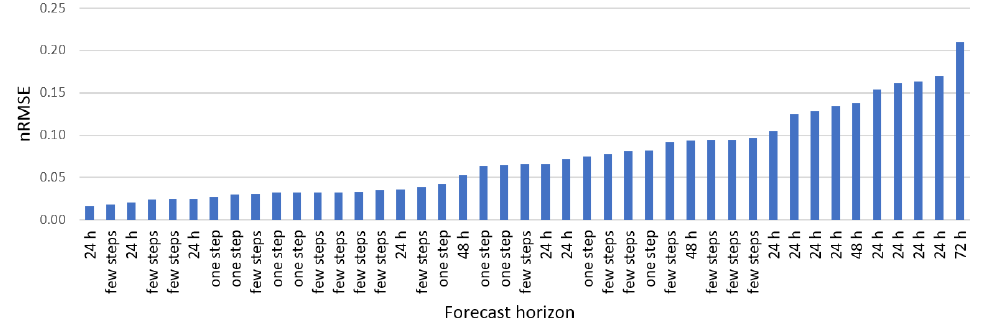
Figure 9. nRMSE errors with a note on forecasting horizon, in ascending order.